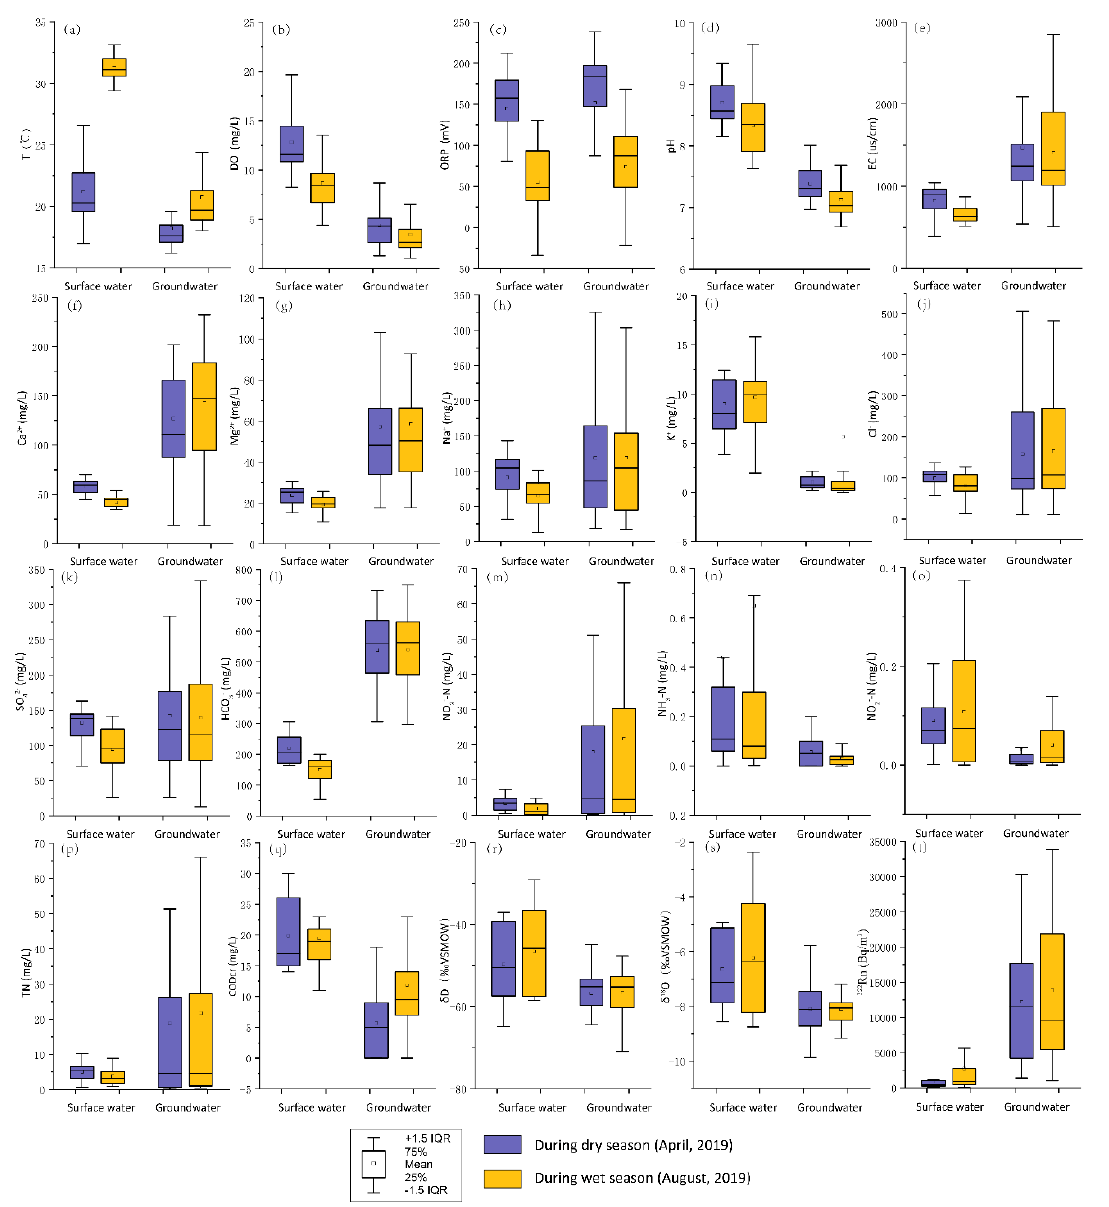
Figure 4. The di ff erence of the indicators in the surface water and groundwater between the dry season Figure 4. The difference of the indicators in the surface water and groundwater between the dry and the wet season ( a – l season and the wet season ( a )–( l ).